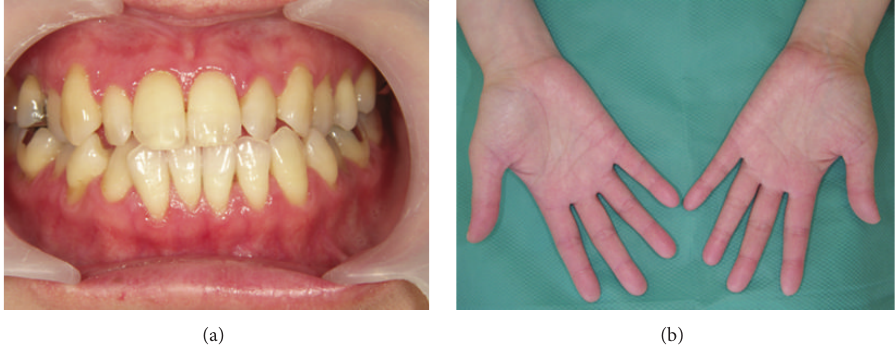
Figure 2: Healed state of the mouth and hand after treatment for